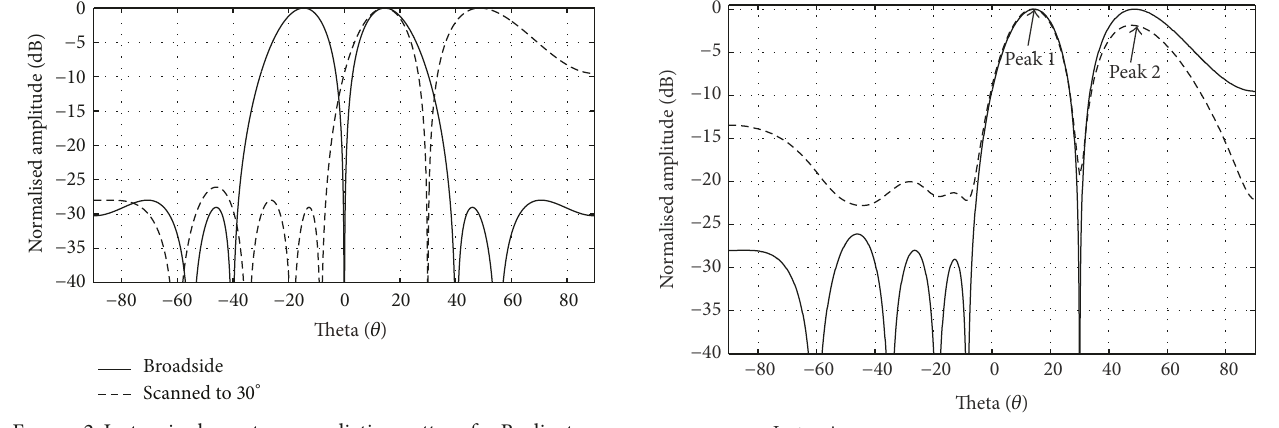
Figure 2: Isotropic element array radiation pattern for Bayliss taper with target SLL = − 30 dB, 𝑑 = 0.4 1 𝜆 , and n = 3 , main null scanned to broadside (solid line) and 30 ∘ (dashed line).